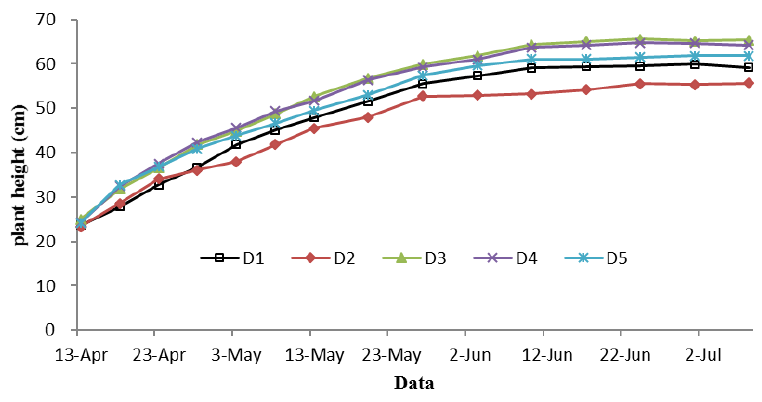
Figure 7. Plant Figure 7. Plant height. Figure 7. Plant height.